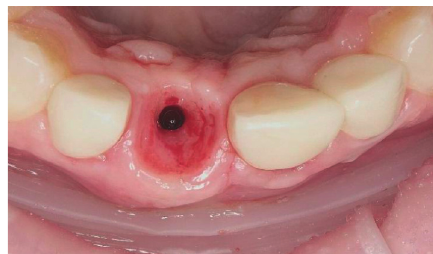
Figure 17: Microruptures in deep layers of the